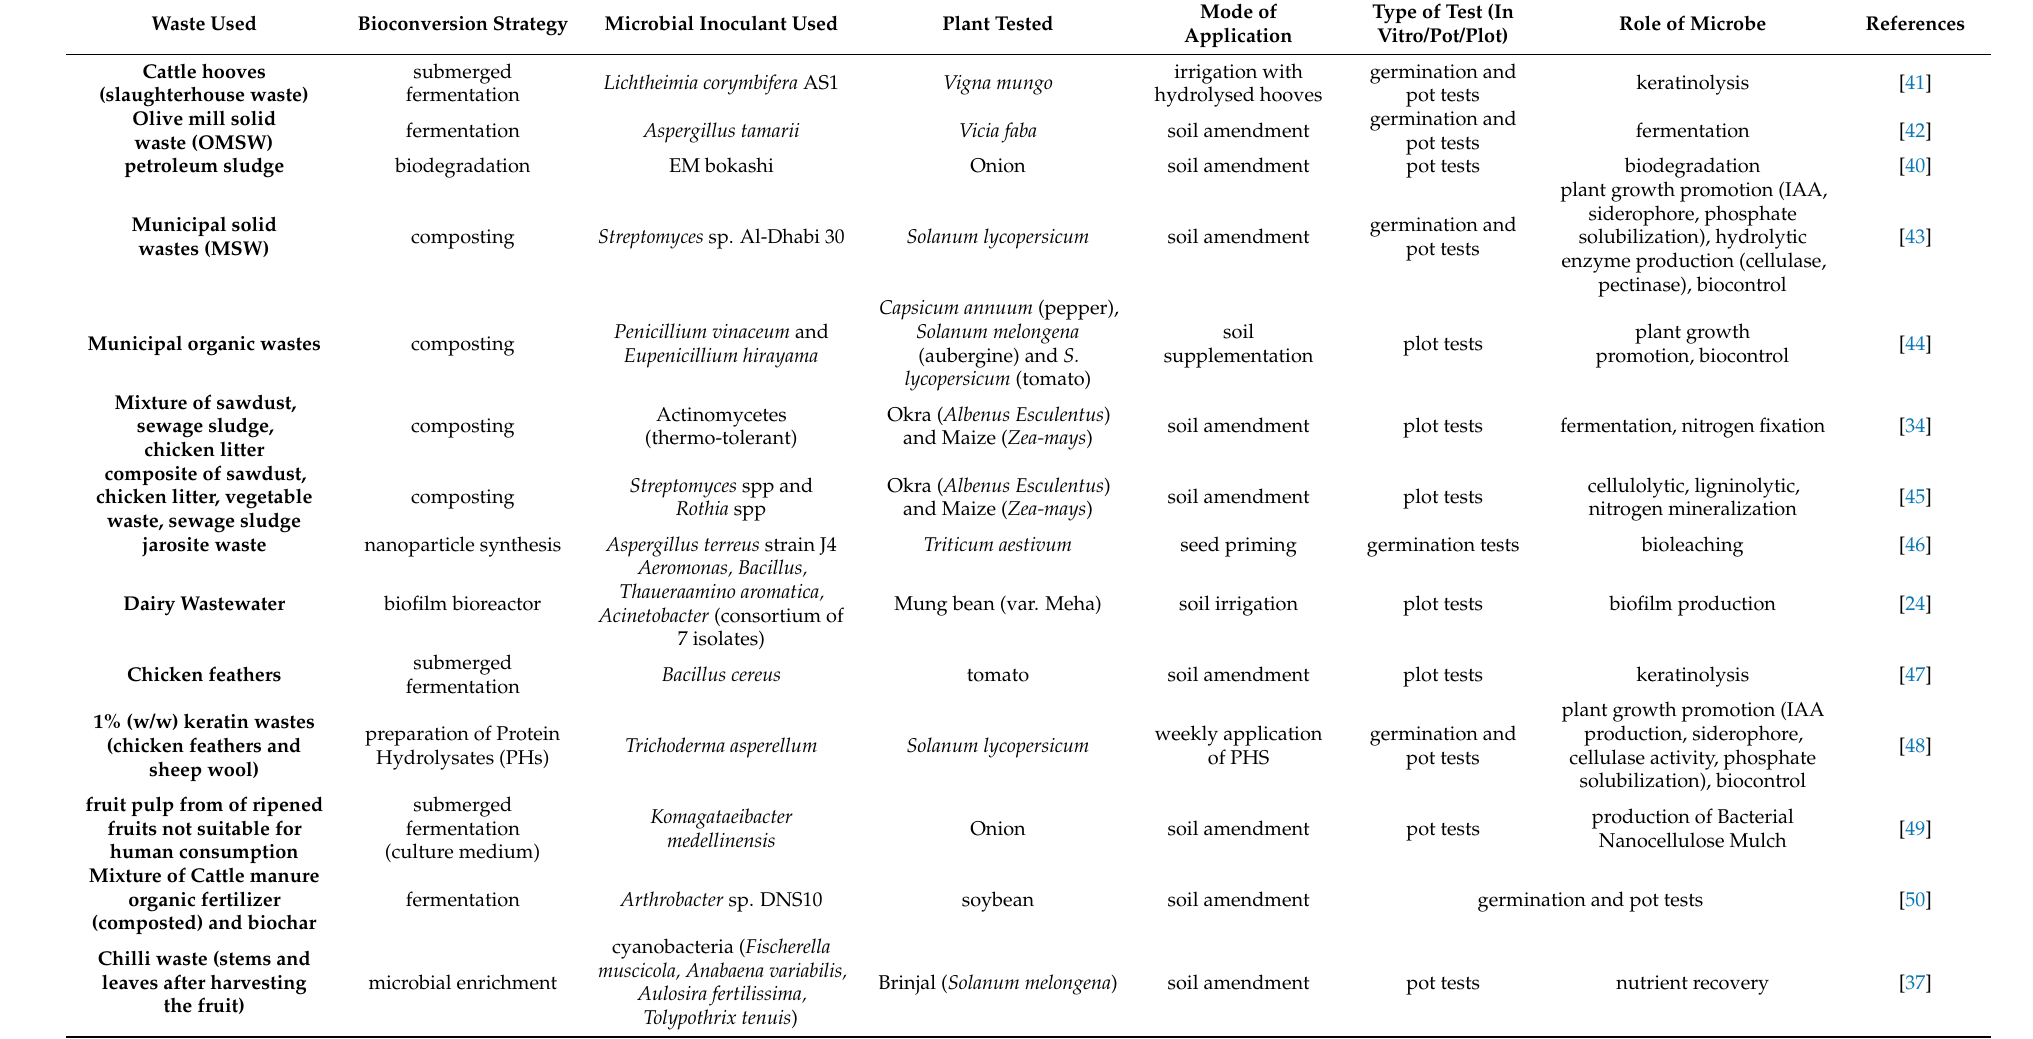
Table 6. Table of evidence (ToE) matrix constructed based on systematic literature review of 74 research